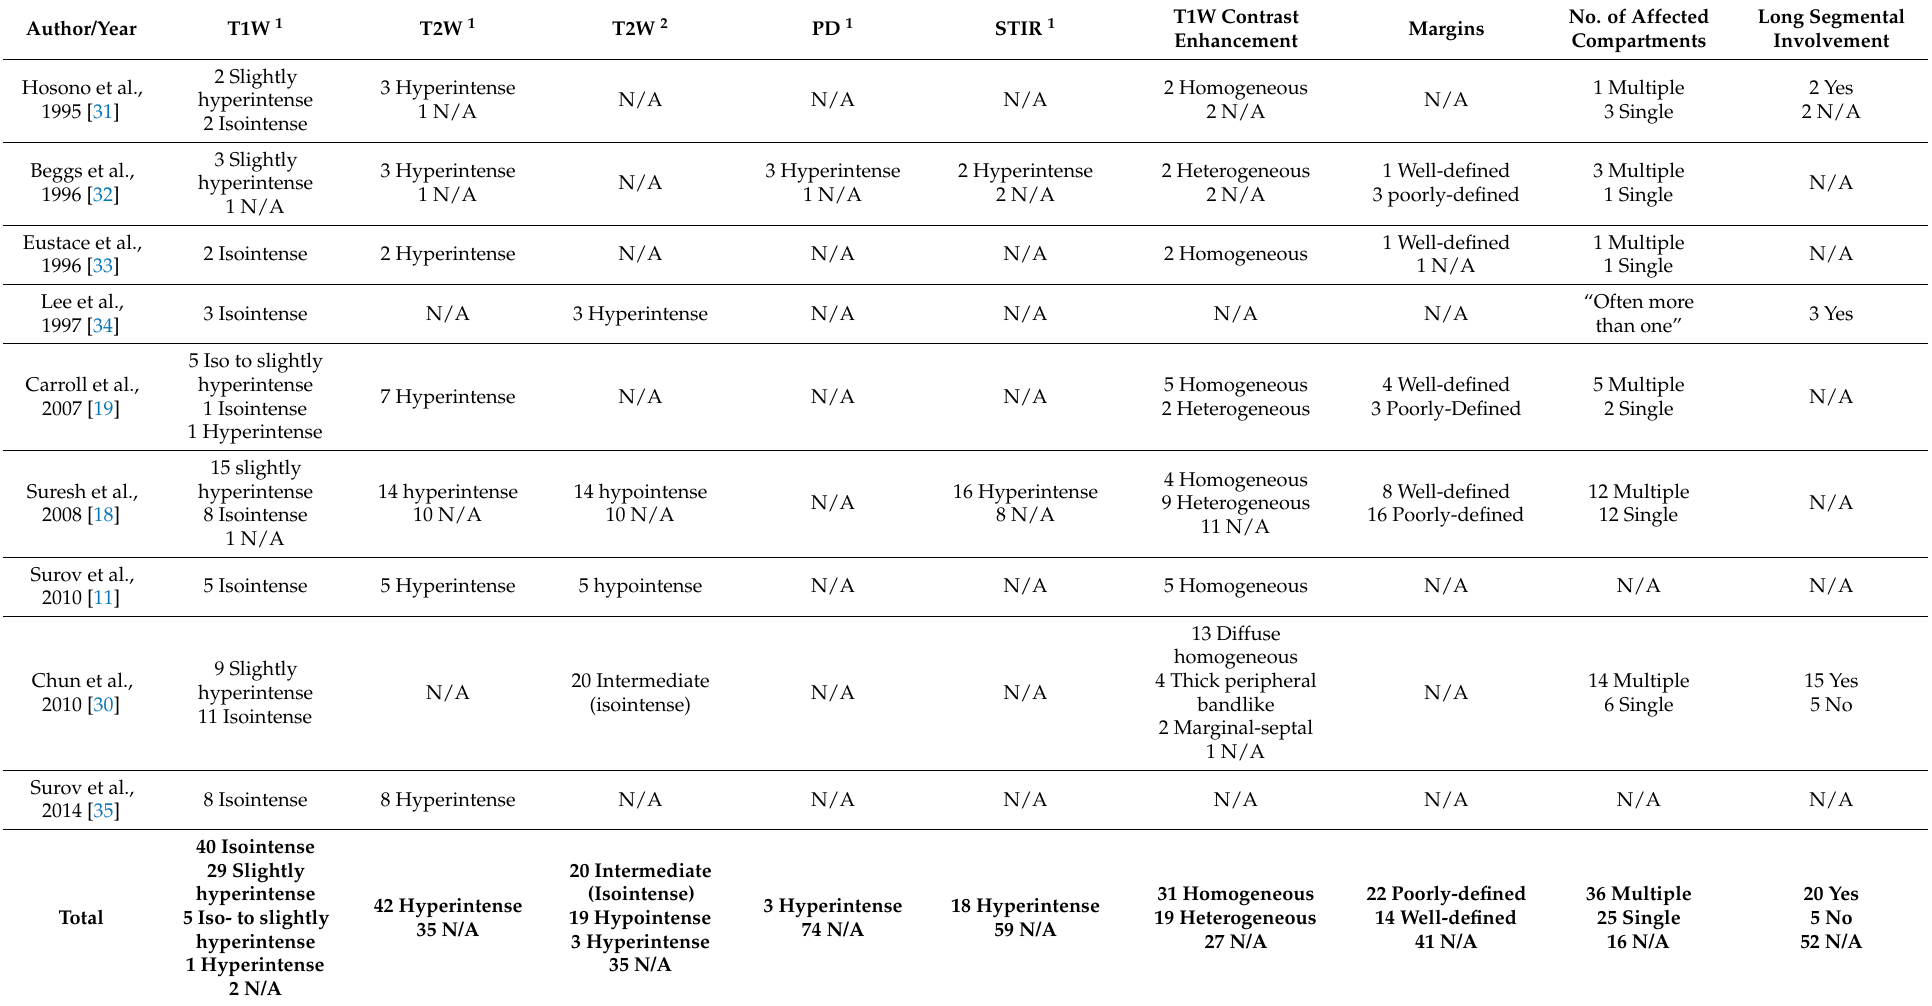
Table 4. Summarized MRI characteristics of included studies (sorted by